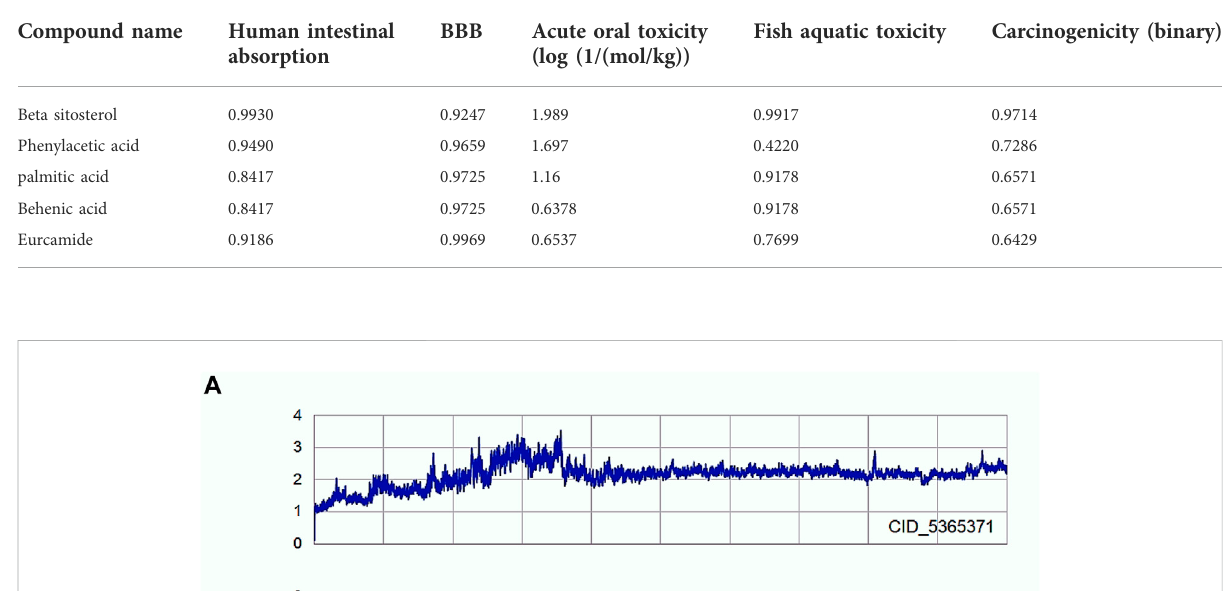
TABLE 3 Predicted ADME physio-chemical properties of the docked compounds, all the tables cited